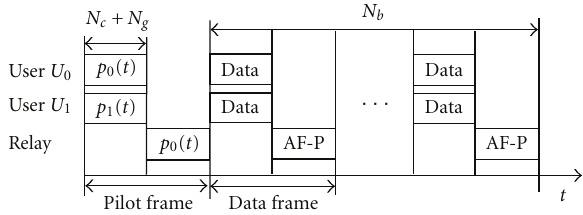
Figure 2: Proposed CE scheme.